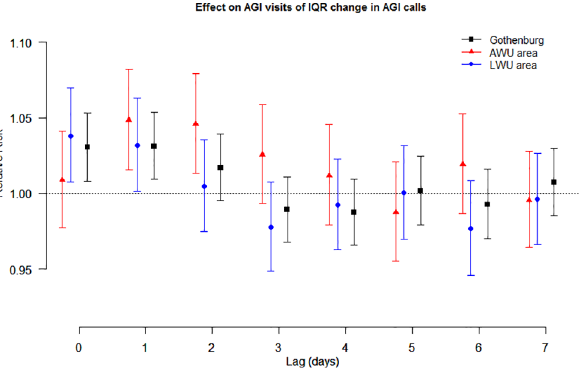
Fig 4. Short-term effect AGI calls on AGI visits. Relative risks of AGI visits across 0 – 7 lag days of an IQR increase of AGI calls. Bars represent 95% confidence